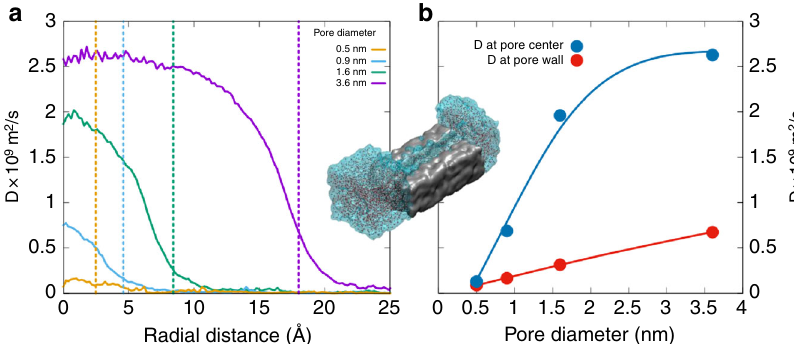
Fig. 4 Water diffusivity in amorphous silica micropores. a Self-diffusion coef fi cient of water as a function of distance from the center of the pore in cylinder pores of amorphous silica with diameters of 0.5, 0.9, 1.6, and 3.6 nm from reactive force fi eld-based molecular dynamics simulations. At the center of the pore, diffusing water molecules do not see the reactive sites in the wall and are relatively less constrained. The inner walls of the pore are oxygen terminated with atomic-scale roughness and reaction with water results in changes in the surface structure. Water molecules have been observed to diffuse up to a nanometer into the silica structure beyond the surface and further change the surface structure. The dashed lines corresponding to the color of the curves represent the approximate location of the pore wall. b Mean water diffusion coef fi cients at the pore wall and at the center of the pore for various pore sizes. In-between fi gures a and b , a snapshot of the 0.9-nm pore system with a section of the silica structure removed to show water in the pore. The silica structure is shown as the gray block and water on either side is shown as molecules inside the transparent